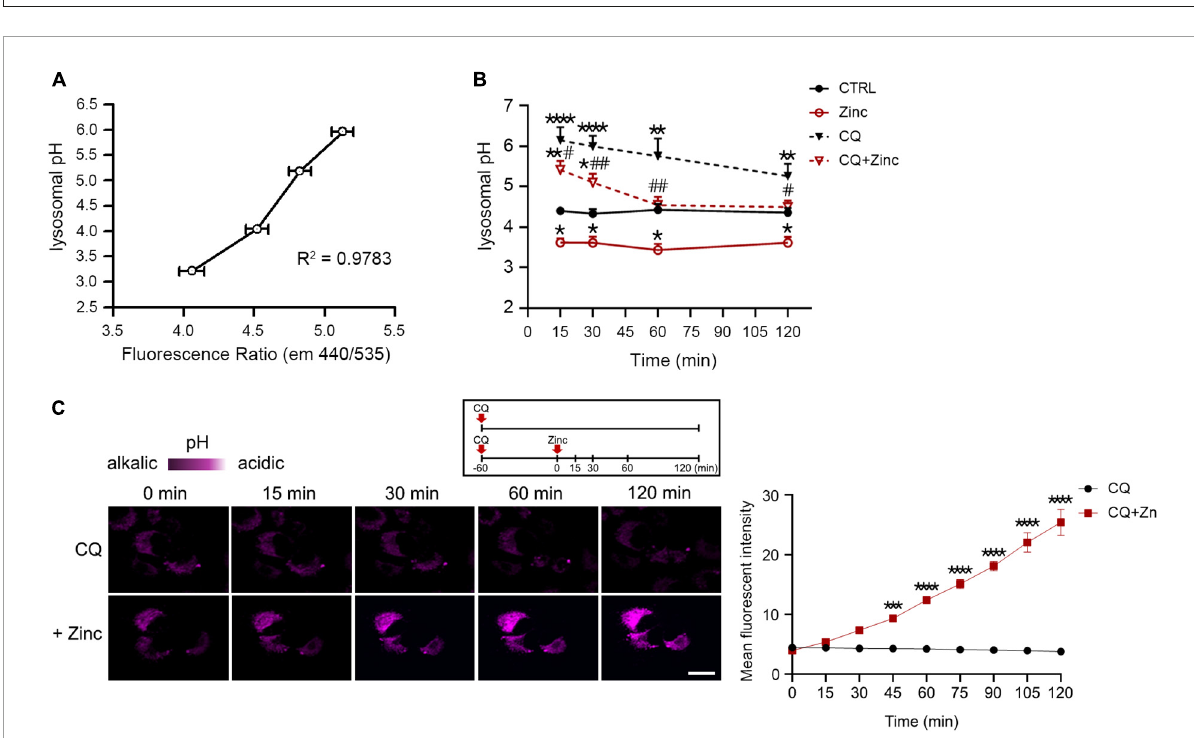
FIGURE5 Zinc rapidly acidifies lysosomal pH. (A,B) Measurement of intra-organellar pH in cerebrocortical neuronal cultures using the ratiometric dye LysoSensor TM Yellow/Blue DND-160. Emission was obtained at 440 and 535 nm for excitation at 340 and 380 nm, respectively. A graph was generated based on the fluorescence intensity ratio (440/535 nm). For the pH calibration curve (A) , pH 3.21, 4.03, 5.18, and 5.96 solutions were used. Lysosomal pH of cortical cultures (B ) was detected at the indicated time points after exposure to sham wash (CTRL), 25 µ M ZnCl 2 , 50 µ M chloroquine, or CQ plus Zinc (mean ± SEM, n ≥ 8 from ≥ 4 independent biological replicate experiments). * p < 0.05, ** p < 0.01 or **** p < 0.0001 vs. sham wash control and # p < 0.05 or ## p < 0.01 vs. CQ alone by ANOVA with post hoc Dunnett’s test. (C) Live-cell confocal microscopy images of H4 cells stained with LysoTracker Red DND-99. Cells were pretreated with 50 µ M chloroquine (CQ) for 1 h, and then the live images were taken with or without 50 µ M ZnCl 2 for an additional 2 h. Scale bar, 20 µ m. The graph represents the mean fluorescent intensity of pseudo-color quantified in 20 cells. *** p < 0.001 or **** p < 0.0001 by ANOVA with post hoc Bonferroni’s